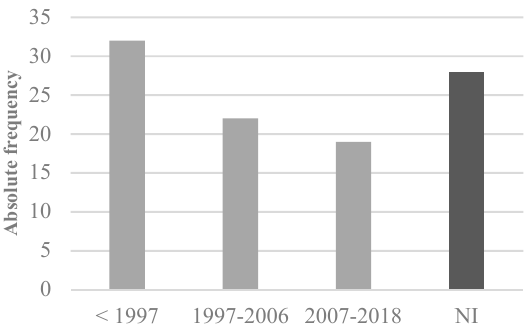
Figure 1. Absolute frequency of the inspected vinyl and linoleum floorings (VLF) according to the construction year (NI - not identified).